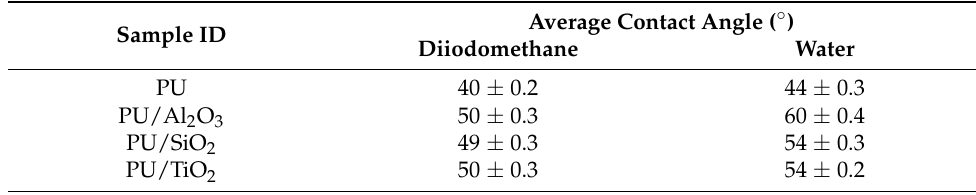
Table 4. The contact angle of the samples for different measuring